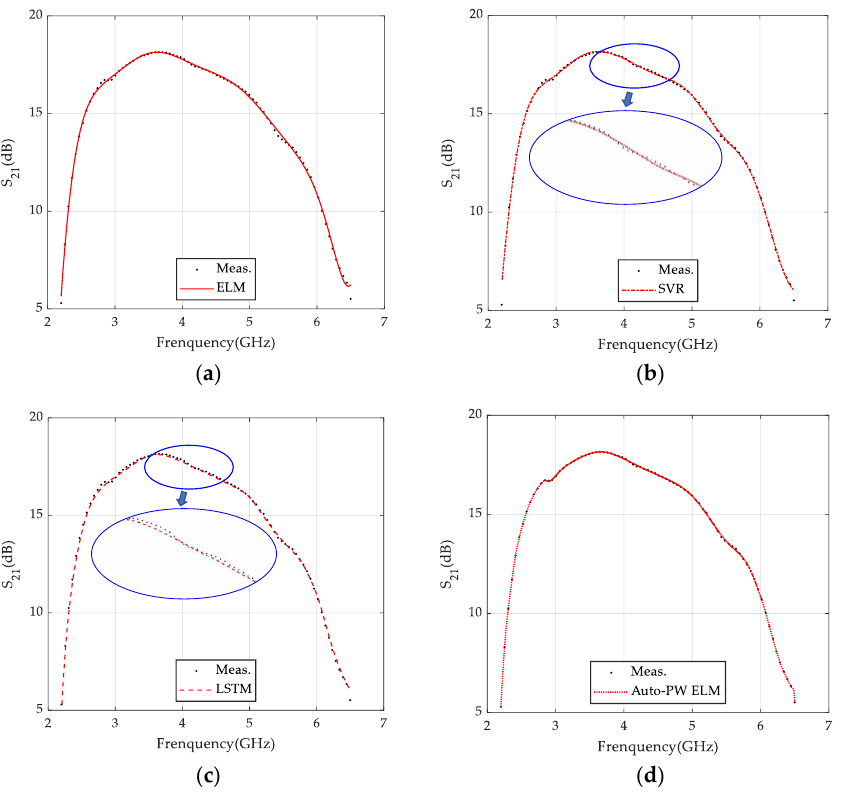
Figure 8. Modeling results of S 21 parameters. ( a ) Comparison of ELM model and measured data. ( b ) Comparison of SVR model and estimated data. ( c ) Comparison of LSTM model and measured data. ( d ) Comparison of automatic piecewise ELM model and measured data.